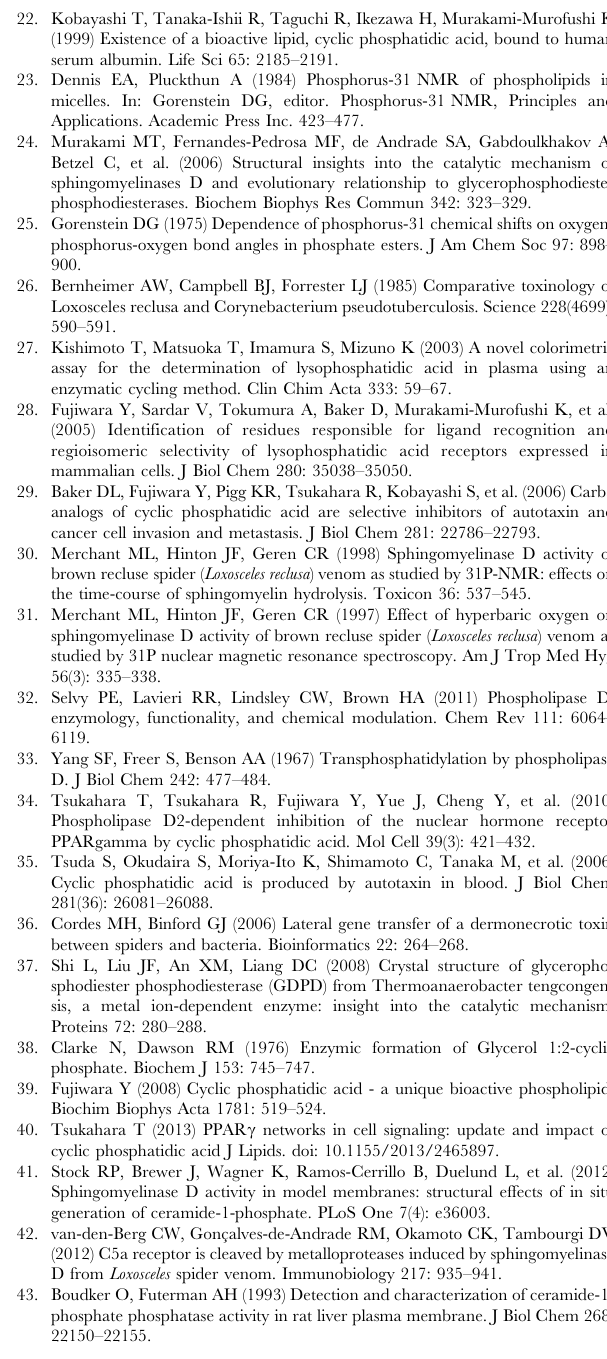
Figure S4 31 P-NMR spectra of commercially available sphingomyelin (SM) derived from chicken egg and N- oleoyl-ceramide-1-phosphate (18:1 C1P) in borate buff- er. A: 4 mM SM with 12 mM Triton X-100. B: 0.5 mM SM, 0.5 mM 18:1 C1P and 4 mM Triton X-100. Trimethyl phosphate (TMP; 1 mM) was added as a chemical shift and